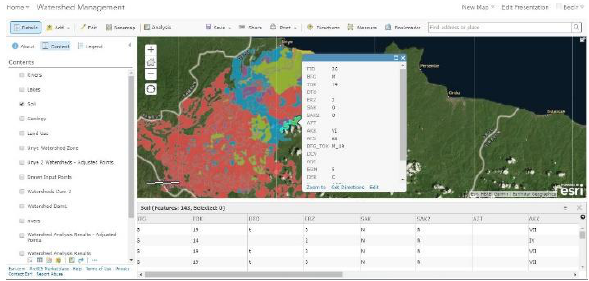
Figure 4: Attribute queries on